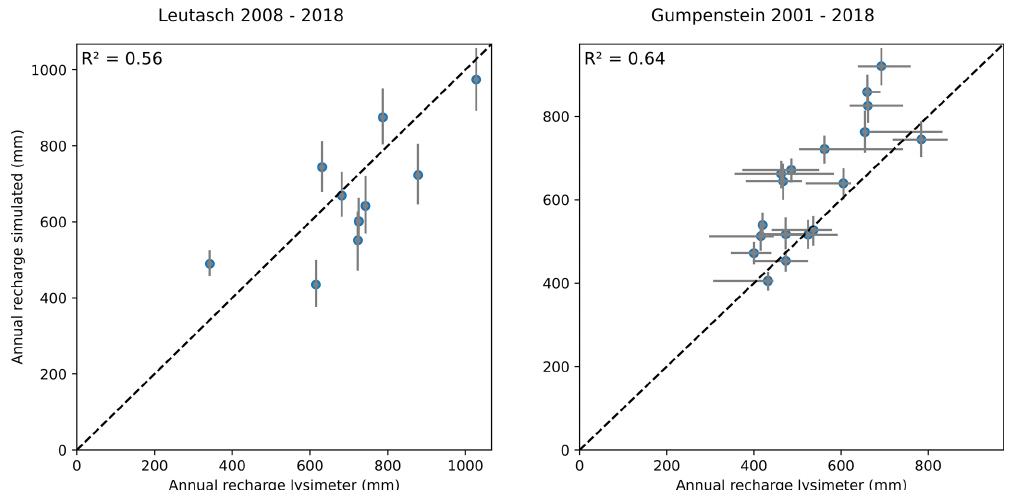
Figure A6. Model validation using lysimeter data from Leutasch and Gumpenstein. Scatterplots and coefficients of determination ( R 2 ) are shown for simulated and observed annual seepage flow. Blue dots show median estimates and the gray error bars depict the 95% credible interval from propagated parameter uncertainty. The dashed diagonal black line is the 1 : 1 line. Leutasch seepage measurements were obtained from a single lysimeter; for Gumpenstein, the 95% uncertainty interval in the lysimeter measurements was calculated from a cluster of four